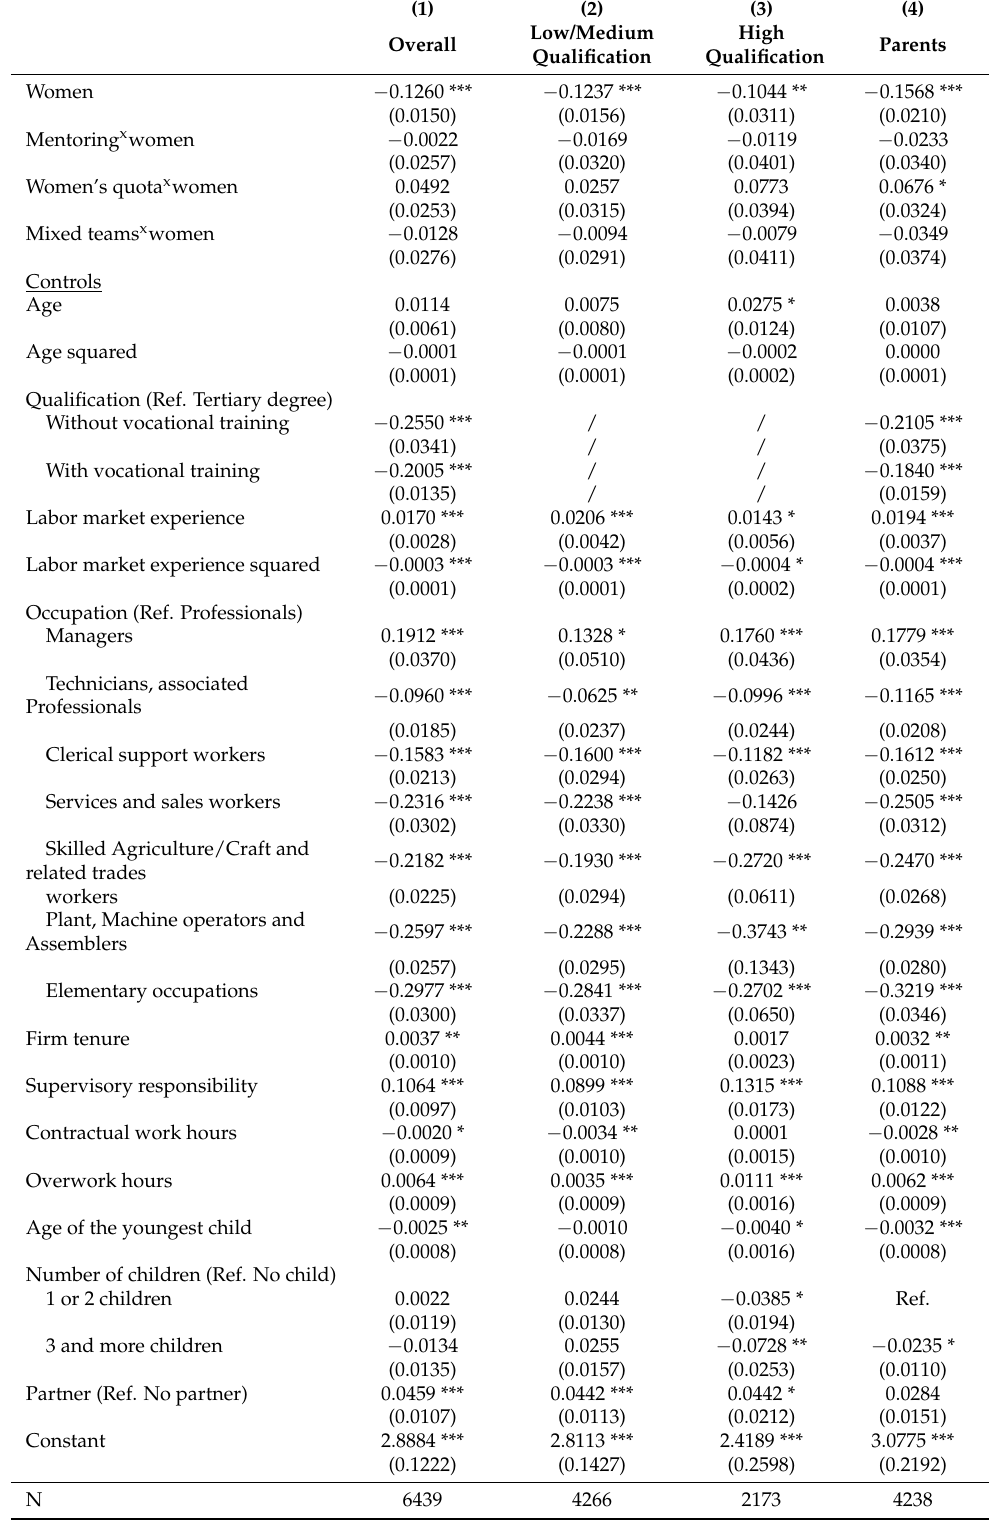
Table A4. The association of equal opportunity measures and log hourly wages including controls (extended version of Table 3, step